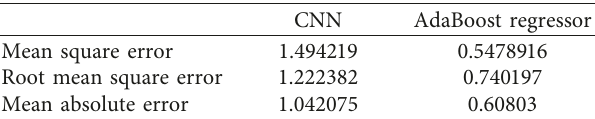
Table 2: CNN and AdaBoost regressor results on MSE, RMSE, and MAE evaluation